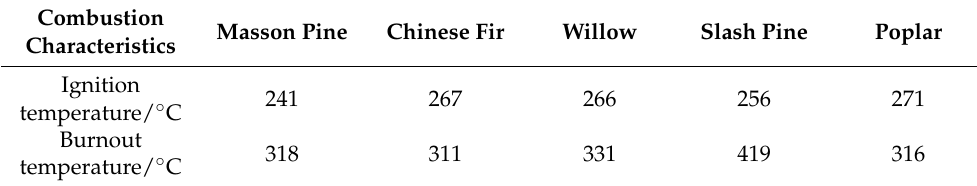
Table 2. Ignition temperature and burn-out temperature. Combustion Masson Pine Chinese Characteristics